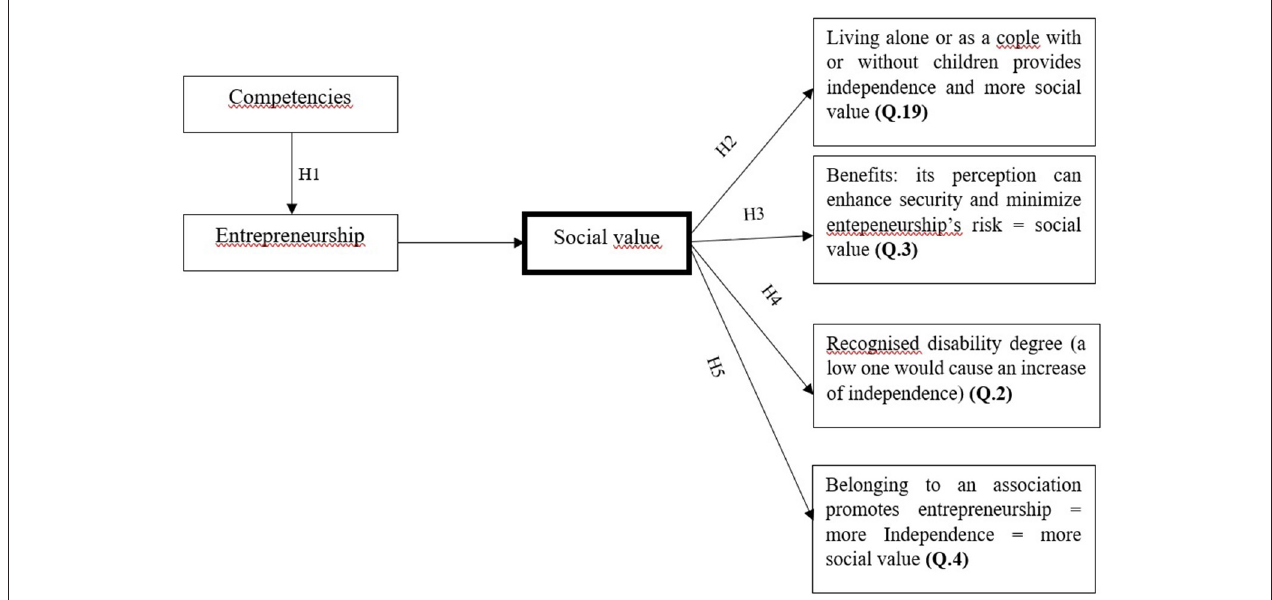
FIGURE 1 | Summarized approach to the analysis of entrepreneurship social value of PWDs. Source: Own elaboration.